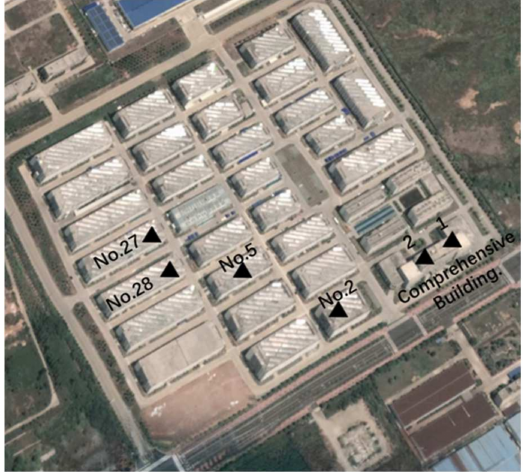
Figure 14. GPS device installation point map.